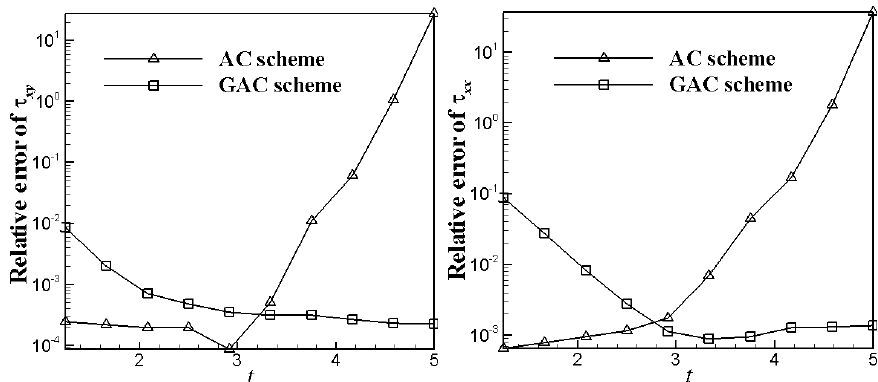
and for y at position x = 5 at Wi = 15.0 xy xx